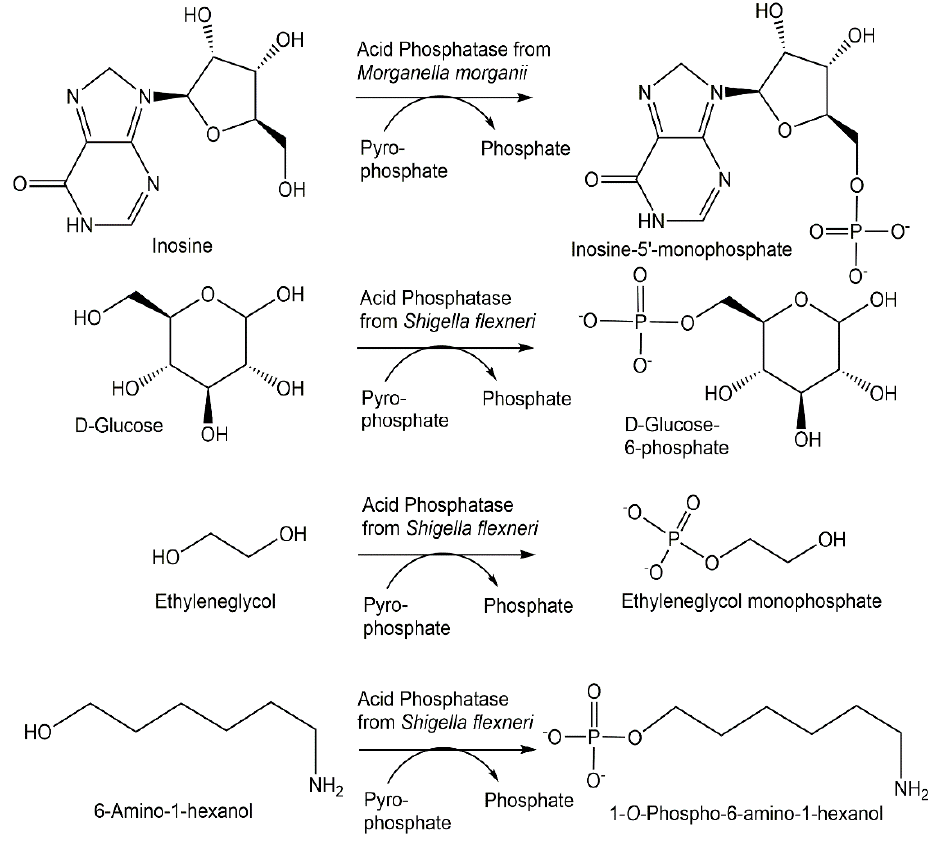
Figure 4. Selected phosphohydrolases for catalyzing phosphorylation reactions.